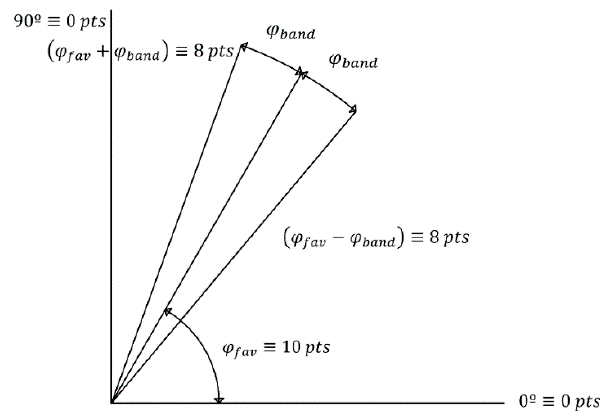
Figure 5. Representation of value assignation according to the favorable inclination angle set.